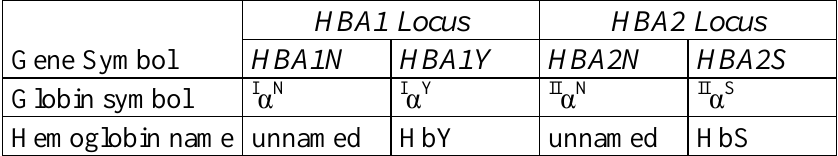
Table 1. Nomenclature of alpha globin genes and products in cattle.